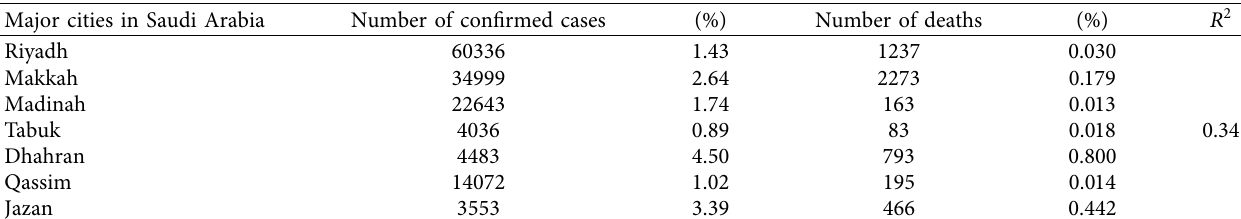
Table 2: Regression analysis for the confirmed and death cases due to COVID-19 in major cities of Saudi Arabia. Major cities in Saudi